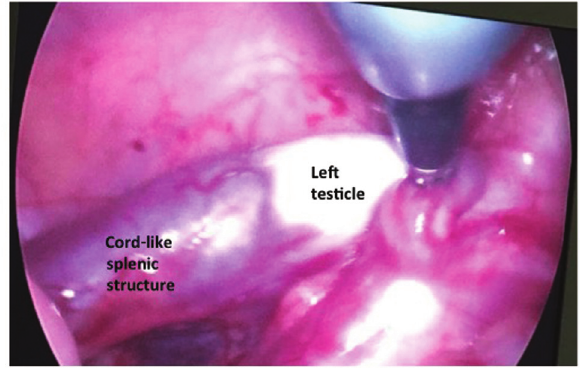
Fig. 3 The cord-like structure composed of splenic tissue lies between the spleen and left